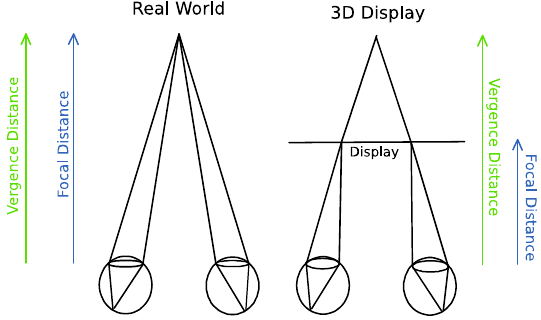
Figure 2: (left) real world: vergence = focal distance. (right) Fo- cal distance always stays the same in